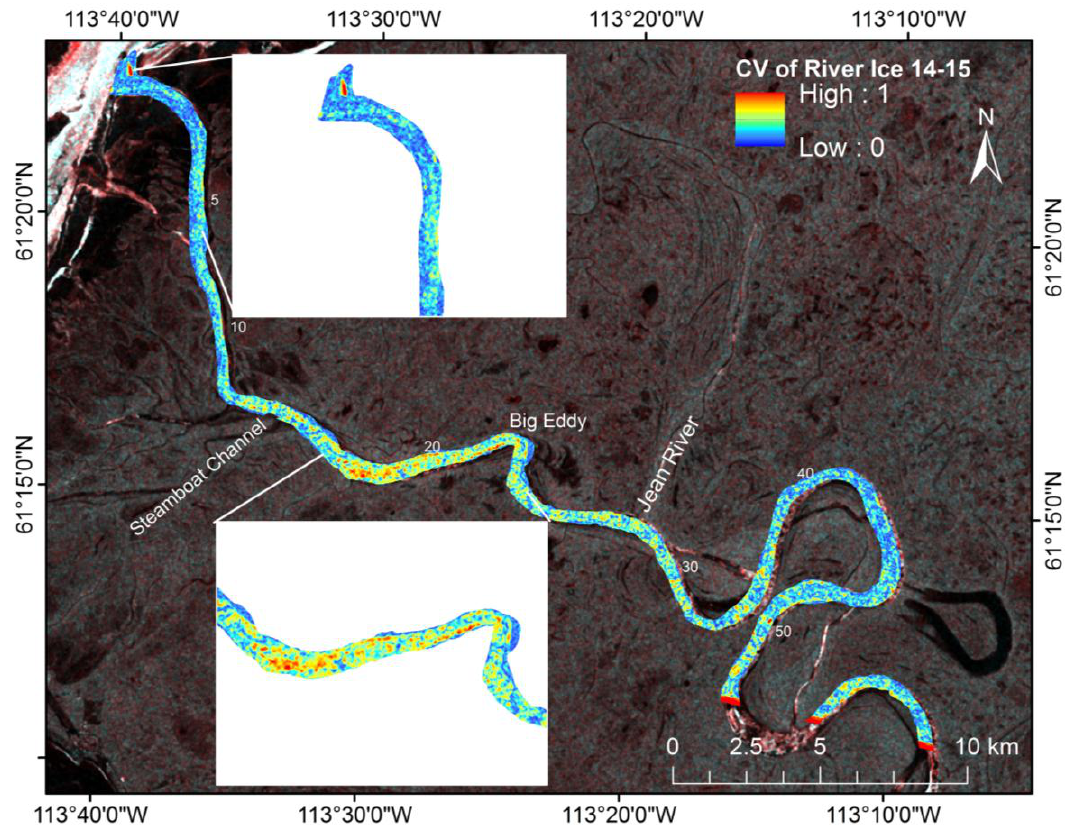
Figure 9. Variation in ice cover along the Slave River Delta channel from December to February in the winter 2014–2015. The number along the river (e.g., 5, 10, etc. ) indicates the kilometer distance from the river mouth at Great Slave Lake. (RADARSAT-2 Data and Products © MacDonald, Dettwiler and Associates Ltd (2013–2015)—All Rights Reserved. RADARSAT is an official trademark of the Canadian Space Agency).